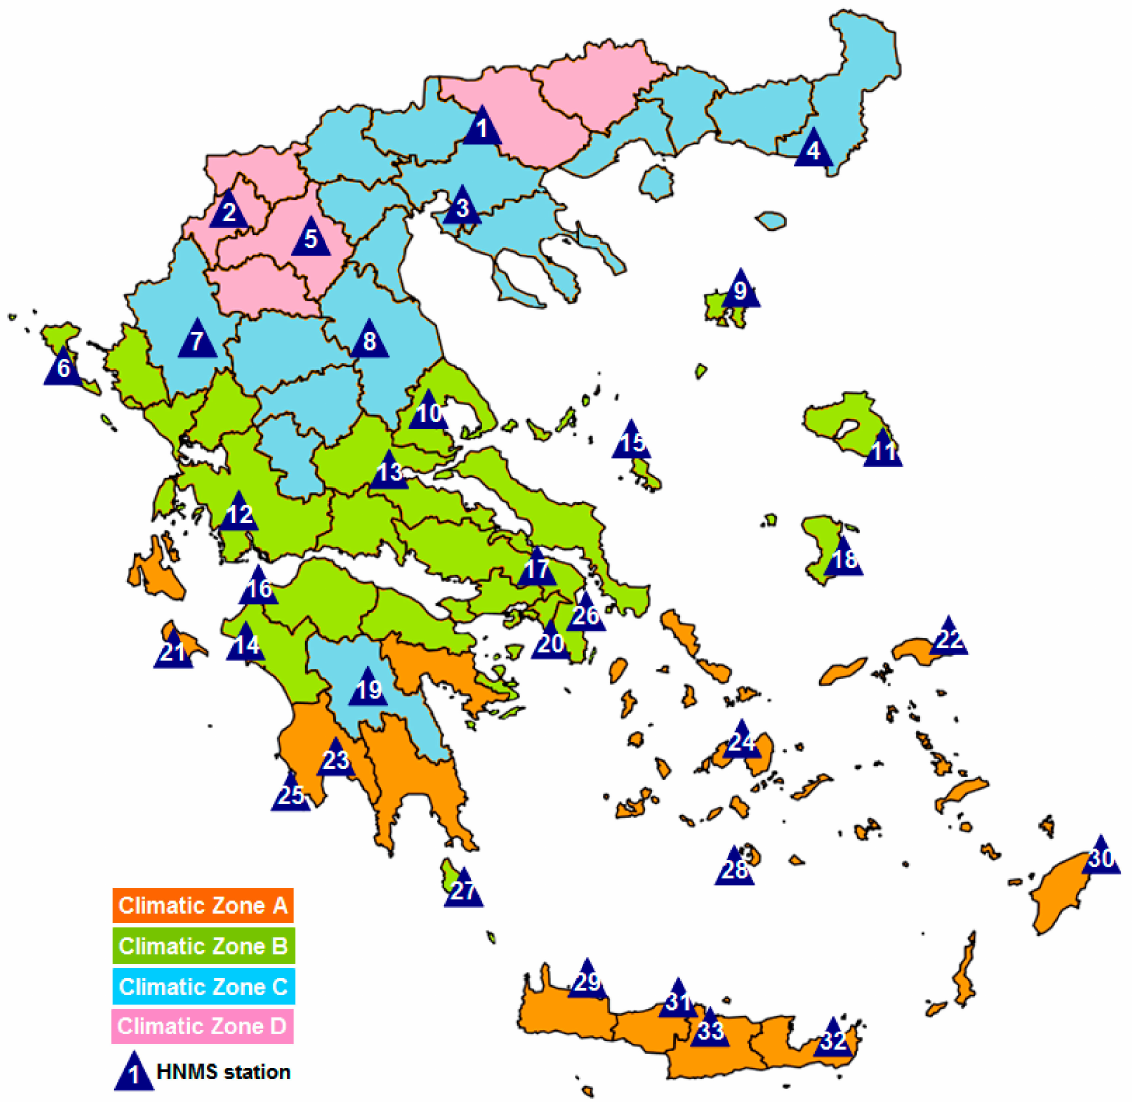
Figure 1. Distribution of the 33 selected HNMS stations (blue triangles) across the 4 climatic zones of Greece for energy purposes (orange = climatic zone A, green = climatic zone B, blue = climatic zone C, and purple = climatic zone D). The numbers on the map inside the triangles refer to the HNMS